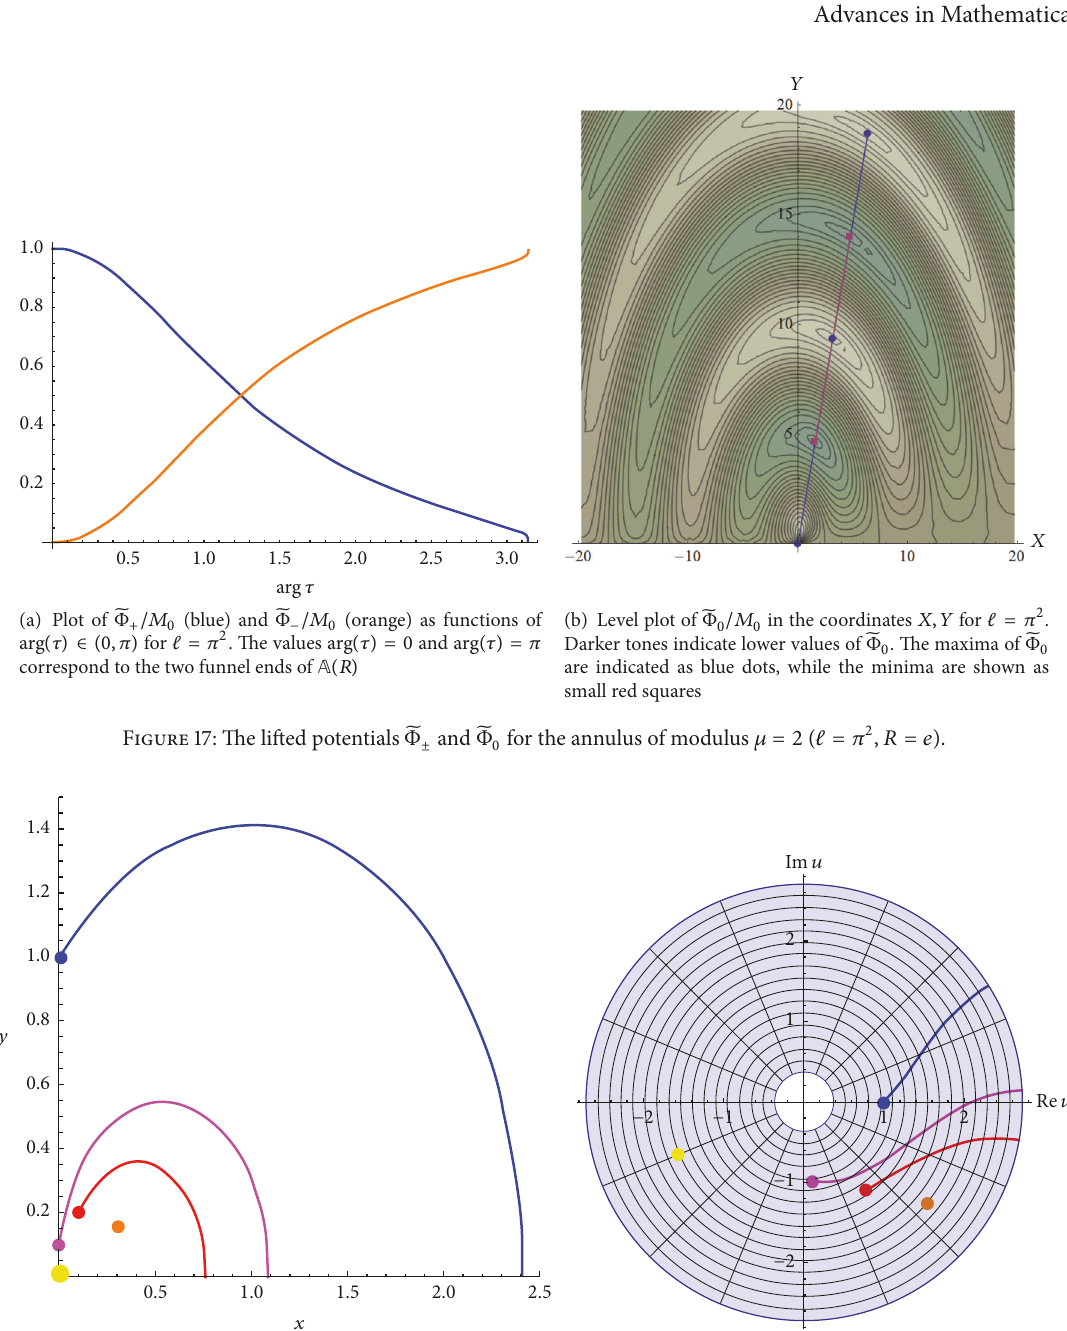
Figure 18: Five trajectories for Φ = 0 , 𝛼 = 𝑀 0 /3 , and ℓ = 𝜋 2 , with initial conditions as in Table